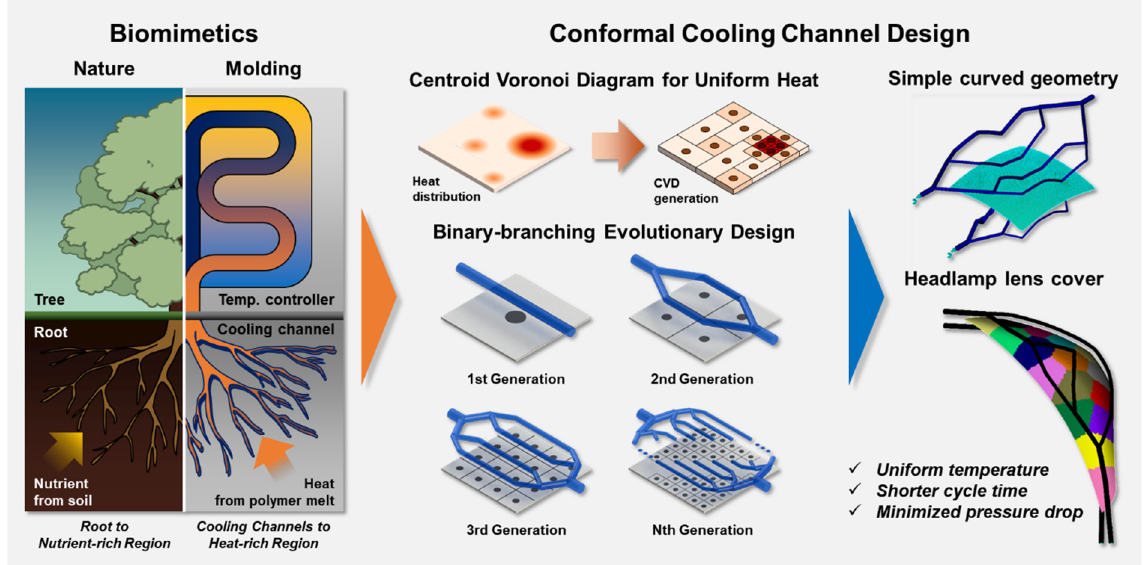
Figure 1. Schematic of biomimetic conformal cooling channel design method.